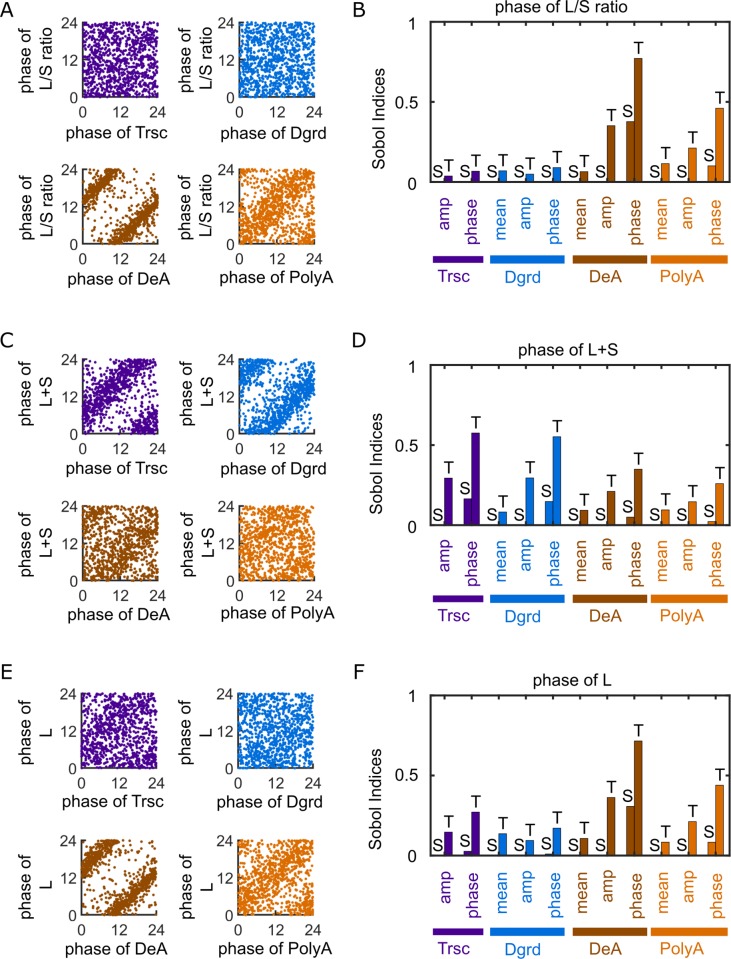
Rhythmicities of poly(A) tail length and long-tailed mRNA abundance are strongly controlled by rhythmic deadenylation.(A) Scatter plot of the peak phases of input processes versus the peak phases of L/S ratio (i.e., poly(A) length metric). (B) Sobol indices for the peak phase of L/S ratio. (C) Scatter plot of the peak phases of input processes versus the peak phases of L+S (i.e., total mRNA abundance). (D) Sobol indices for the peak phase of L+S. (E) Scatter plot of the peak phases of input processes versus the peak phases of L (i.e., long-tailed mRNA abundance). (F) Sobol indices for the peak phase of L. (A, C, E) Each scatter plot shows 10,000 data points randomly chosen from the original simulations for the sake of visual clarity. (B, D, F) Bars with “S” on top: single Sobol indices. Bars with “T” on top: total Sobol indices. Mean values of the Sobol indices are shown, because the variances are too small for clear visualization (S2 Fig).